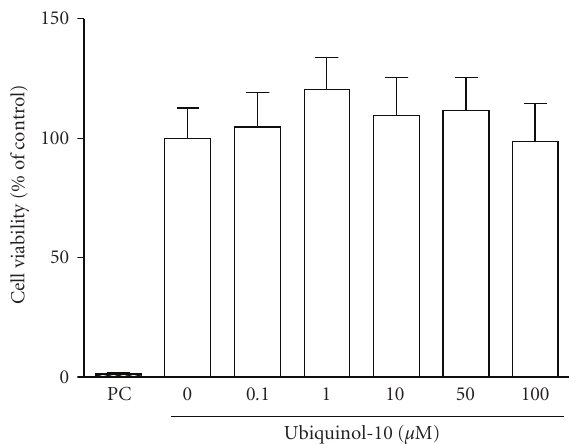
Figure 1: E ff ect of ubiquinol-10 on viability of THP-1 monocytes. THP-1 cells were treated with medium, 0.1–100 μ M ubiquinol-10, or 10% DMSO (PC, positive control) for 24 hours. Afterwards, cell viability was determined based on ATP measurements. The viability of medium control was set to 100%, and the other values were referenced to it. Data are means ± SD of three independent experiments performed in